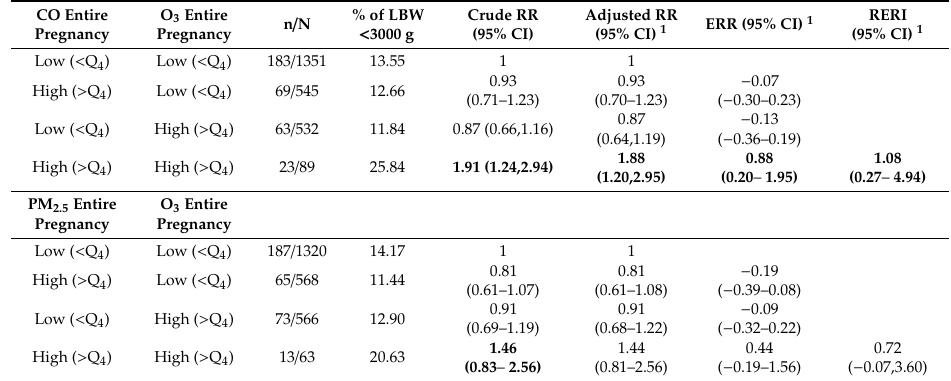
Table 5. Joint e ff ect of CO and O 3 and of PM 2.5 and O 3 during entire pregnancy on low birth weight